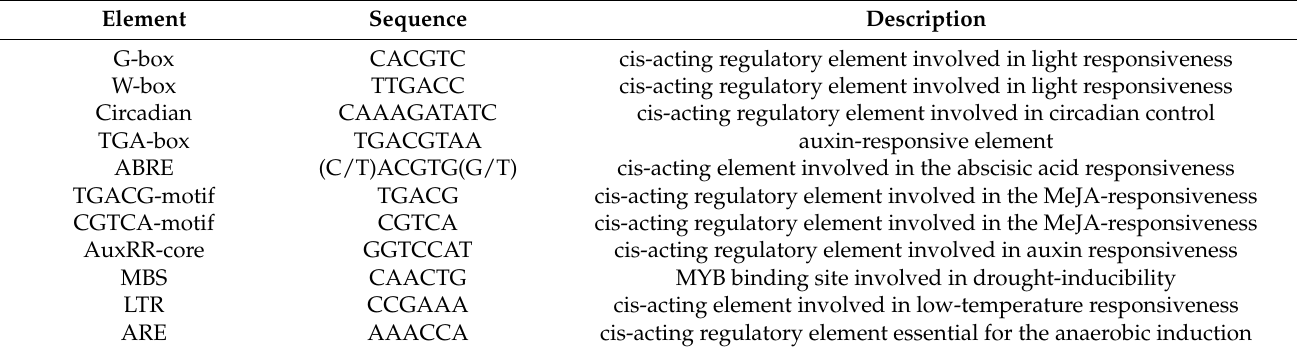
Table 2. Summary of cis-acting elements of CsCAMTA genes.